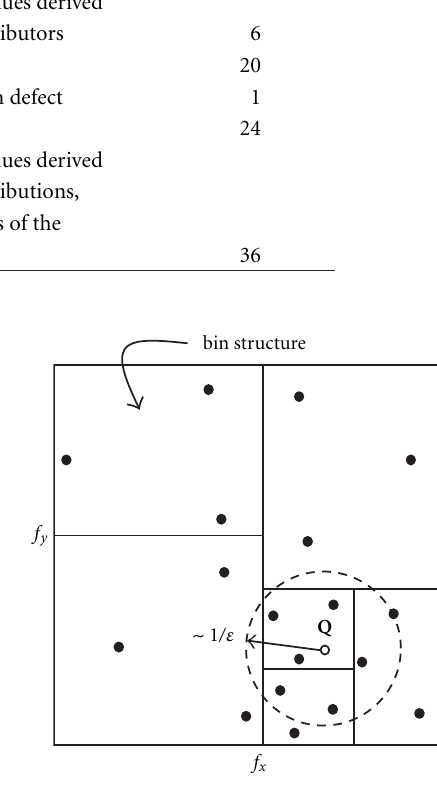
Figure 4: Example of kd-tree bin structure showing the ANN search region about a query point, Q